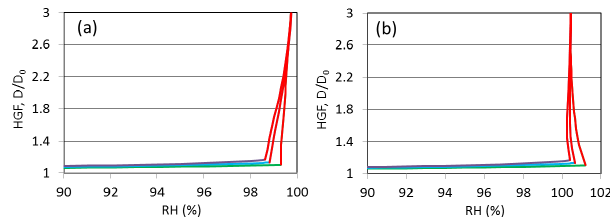
Figure 4. Simulated hygroscopic growth factors HGF = D /D 0 for SOM-high (green, O:C = 0.472), SOM-low (blue, O:C = 0.513) and SOM-ox (purple, O:C = 0.582). The red segments on the lines indicate the presence of LLPS. Panel (a) corresponds to a dry di- ameter of 20µm, which is similar in size to the particles used in the optical microscope experiments, and a surface tension of water. Panel (b) corresponds to a dry diameter of 100nm and a surface tension of water.